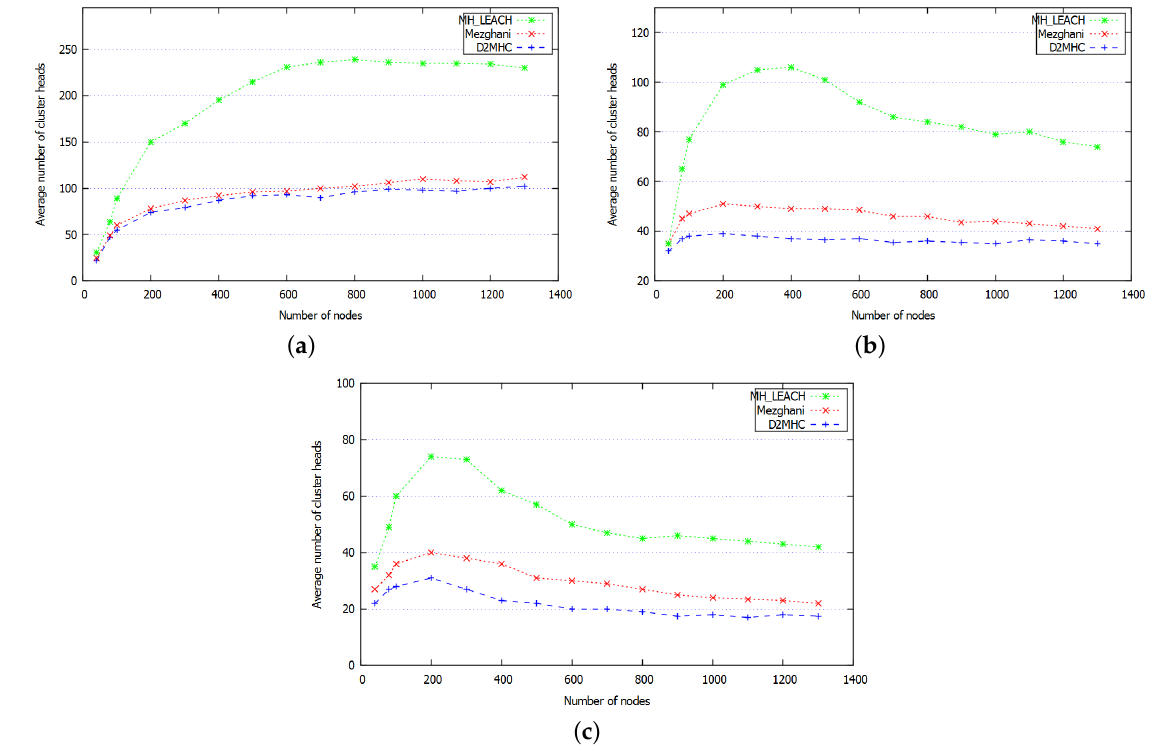
Figure 12. Average cluster head cardinality using the k-hop intra-clustering ( a ) k = 1, ( b ) k = 2, ( c ) k = 3. Table 5. Synthesis of the average CH’s cardinality gains compared with Mezghani and